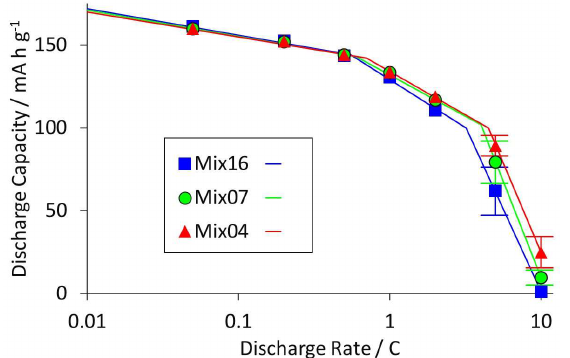
Figure 3. Variation in discharge capacity with discharge rate for three coatings with different car- bon nano-tube contents. nano-tube